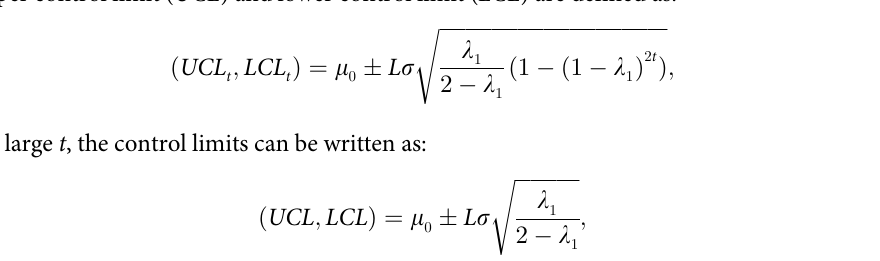
ffiffiffiffiffiffiffiffiffiffiffiffiffiffiffiffiffiffiffiffiffiffi p ffiffiffiffiffiffiffiffiffiffiffiffiffiffiffiffiffi s 2 ð 1 (cid:0) r 2 Þ Y